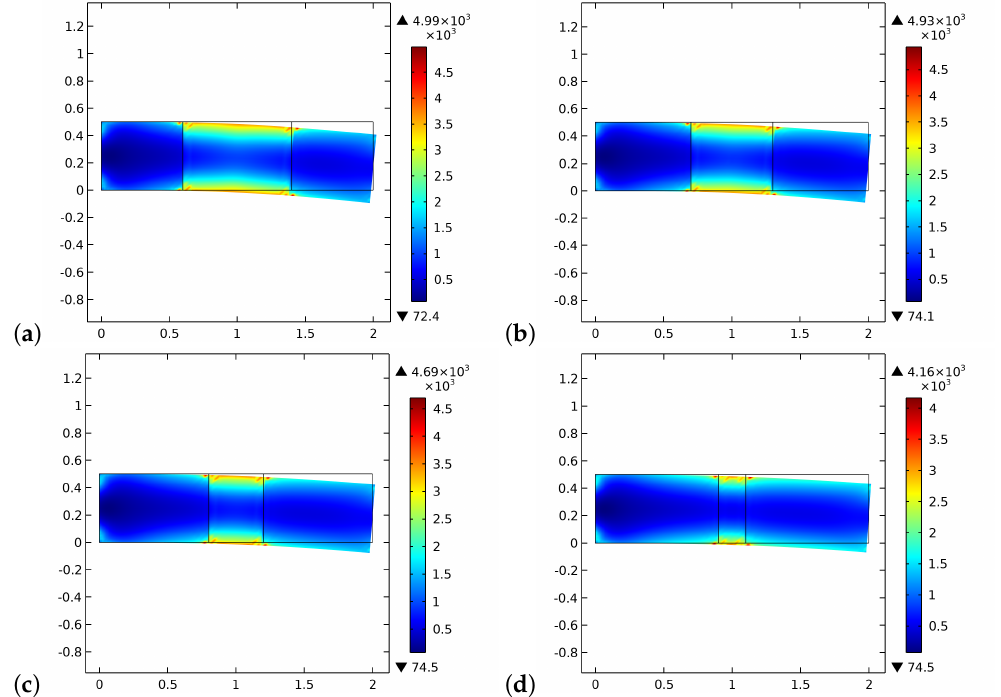
Figure 9. The distribution of the energy density E at the end of the time of simulation for different substitute lengths of the graft: ( a ) 0.8 cm. ( b ) 0.6 cm. ( c ) 0.4 cm. ( d ) 0.2 cm. Figures 10 and 11 plot the initial and final distributions of the dissipated energy density.